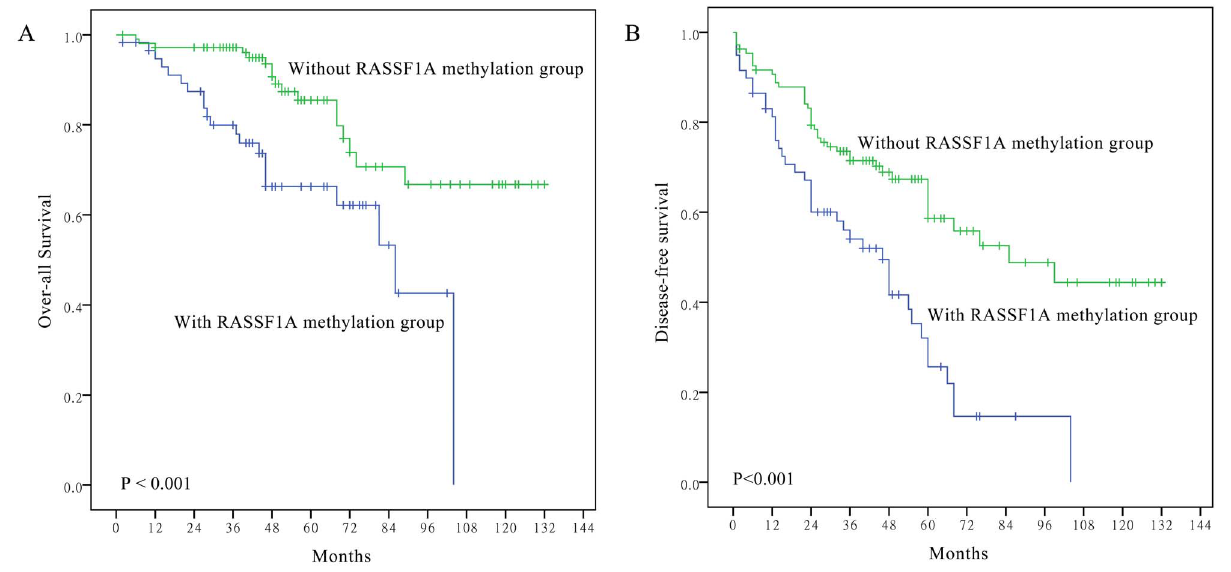
Figure 4. Kaplan–Meier survival curves according to RASSF1A promoter methylation status. Patients with RASSF1A promoter methylation showed poorer over-all survival (A) ( P , 0.001) and disease-free survival (B) than those without ( P , 0.001).